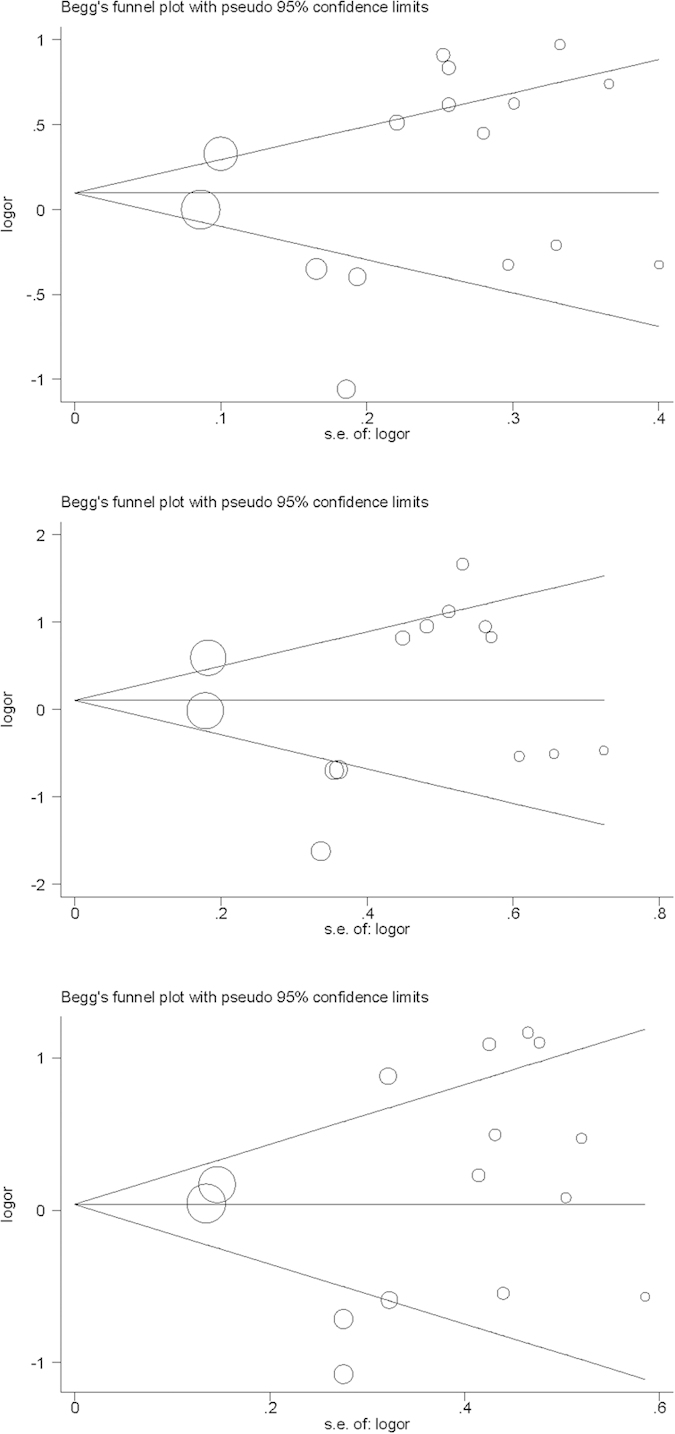
Begg’s funnel plots for the I allele versus D allele (the upper), II genotype versus DD genotype (the middle), and II plus ID genotypes versus DD genotype (the lower).